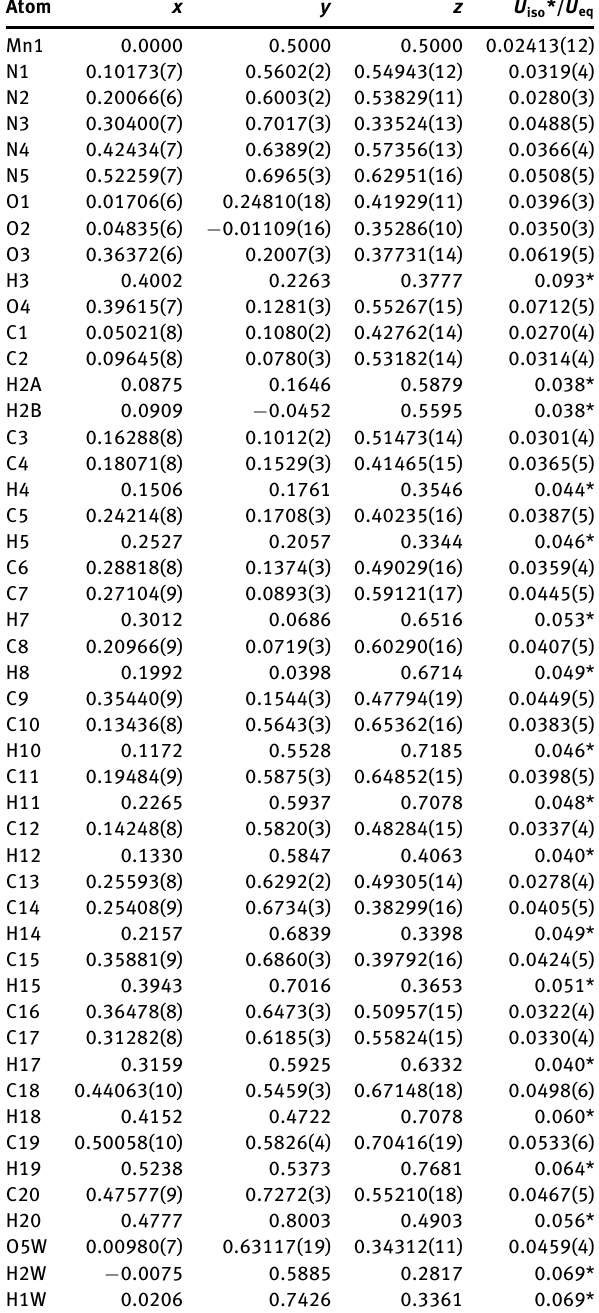
Table 2: Fractional atomic coordinates and isotropic or equivalent isotropic displacement parameters (Å 2